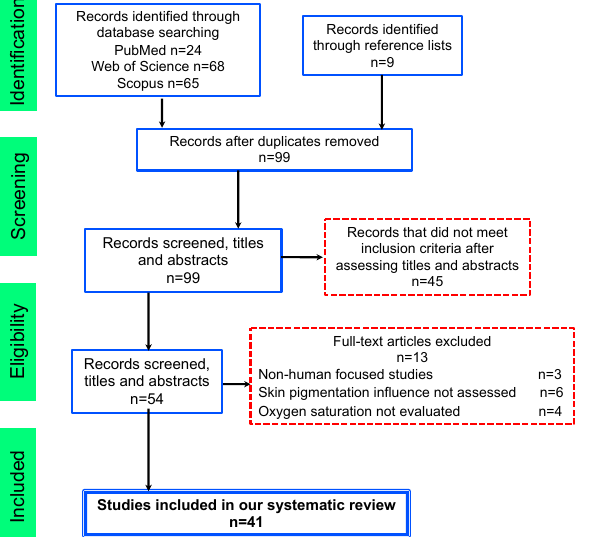
Figure 1. Flowchart consistent with preferred reporting items for systematic reviews (PRISMA) statement.